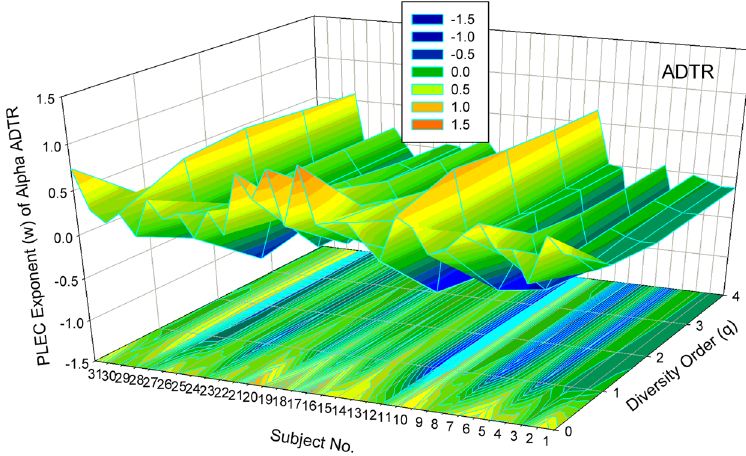
Figure 3. The 3D-graph of the PLEC exponent ( w ) of alpha alpha - DTR.